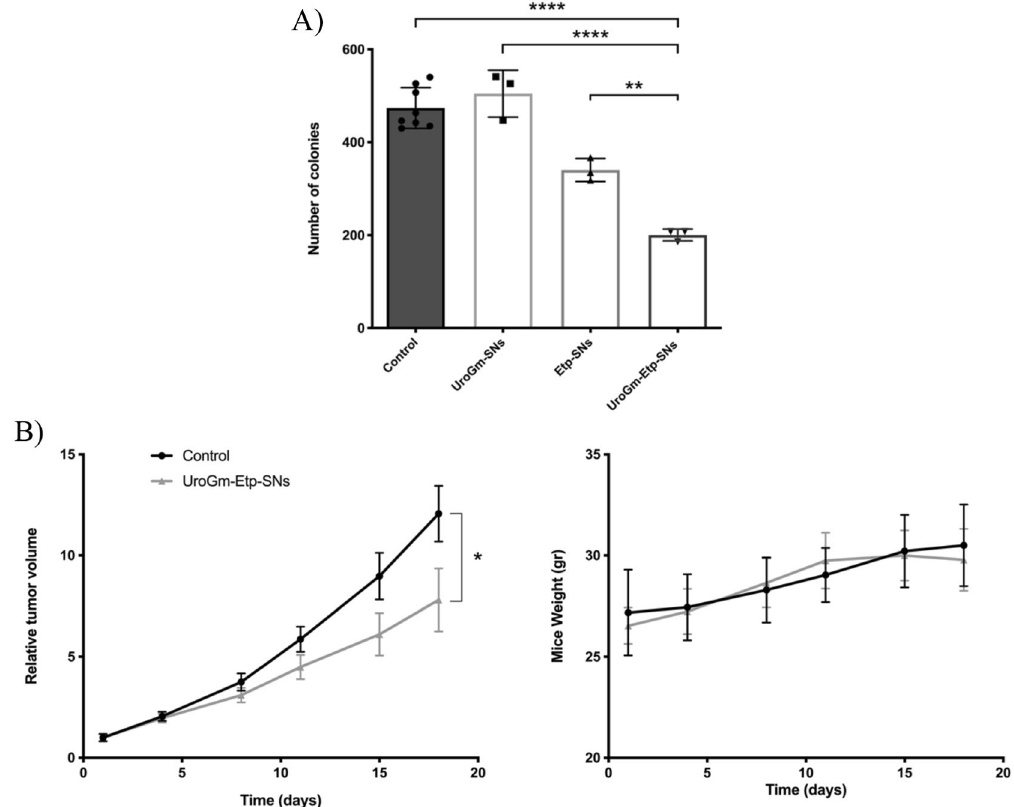
Figure 5. Graphical representation of ( A ) in vitro treatments evaluated in this work (UroGm-SNs, Etp-SNs and the combination UroGm-Etp-SNs) all at the same concentration of the active drugs (500 nM Etp and 50 nM UroGm). ( B ) In vivo a ntitumor effect in terms of relative tumor volume growth and evaluation of mice body weight. Data presented for control mice and UroGm-Etp-SNs treated mice (n = 6). P values: **** p < 0.0001, ** p between 0.001 and 0.01 and * p <